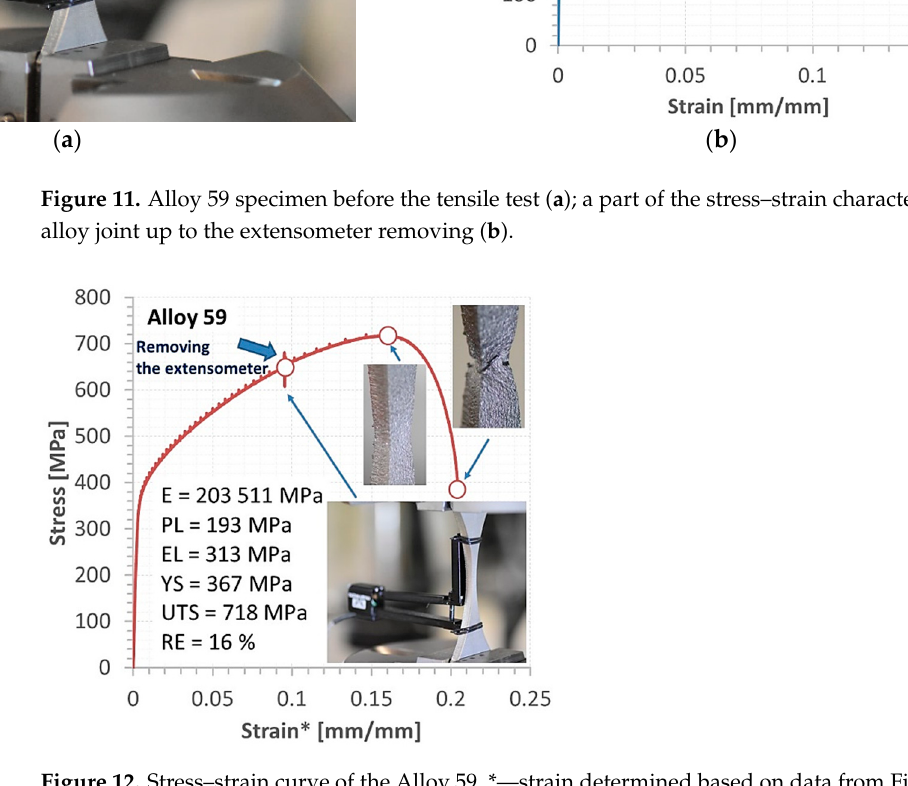
Figure 13. Tensile characteristics and mechanical parameters of S355J2W+N steel. Figure 14. Tensile curve of the MIG weld for Alloy 59 and S355J2W+N steel.